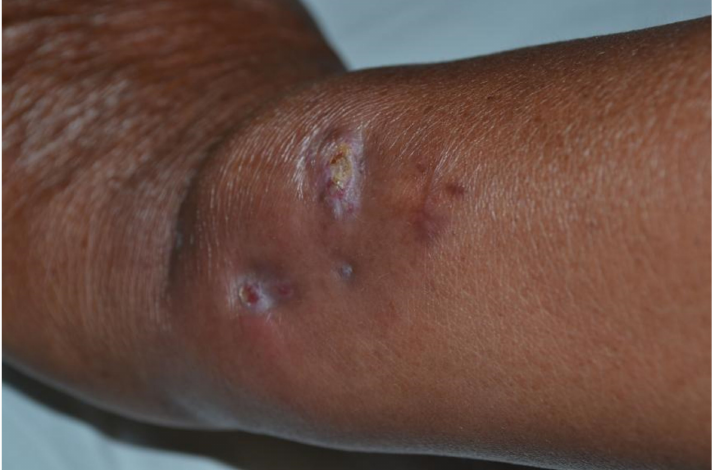
Figure 4. The patient achieved complete remission of the disease at the four-month